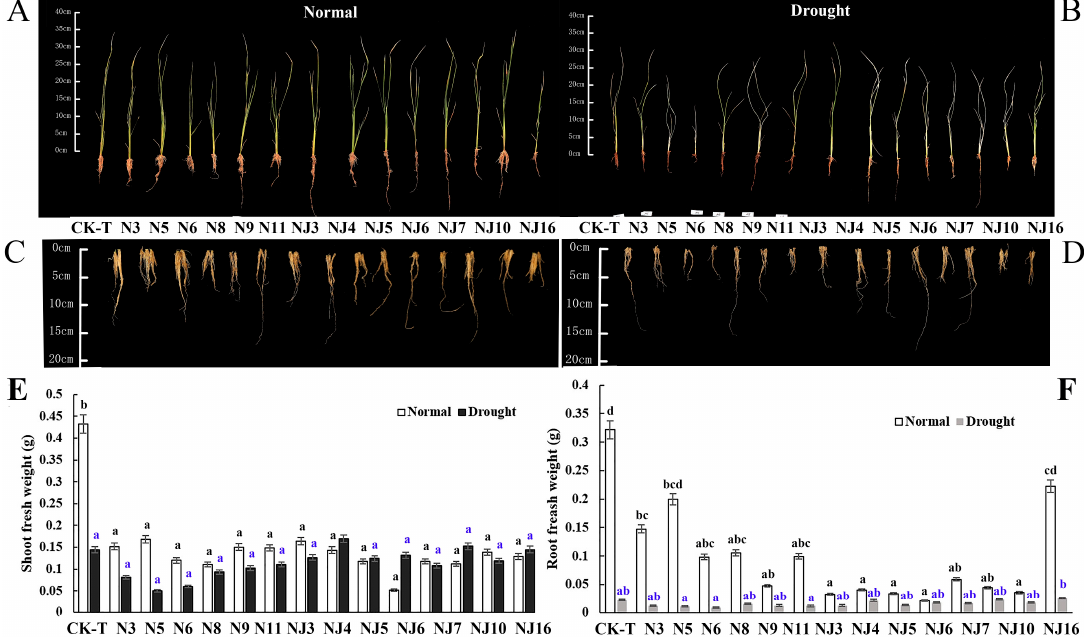
Figure 4. Differential bacterial effects on rice growth and drought tolerance. ( A – D ) Representative images of rice shoot and root inoculated with endophyte and rhizosphere bacteria compared to non-inoculated plants under well-irrigated and drought stress. ( A ) Rice images under well-irrigated. ( B ) Rice images under drought stress. ( C ) Rice root images under well-irrigated. ( D ) Rice root images under drought stress. ( E ) Shoot fresh weight. ( F ) Root fresh weight. N = 15. Different lowercase letters indicate significant differences of shoot or root fresh weight among treatments (ANOVA analysis, Means followed by the same letter are not significantly different, P = 0.05).